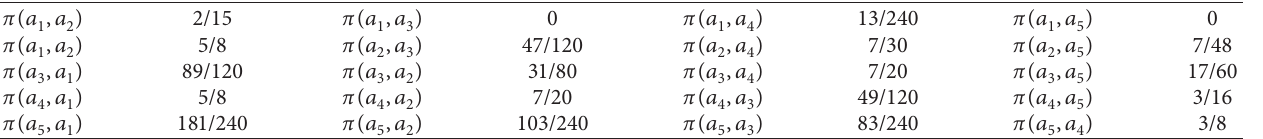
Table 3: Economic criteria priority index.